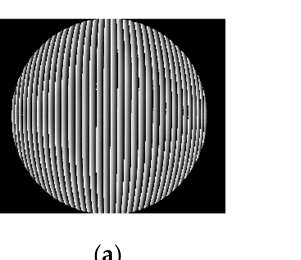
Wrapped phase of distorted transverse fringe-pattern transverse. phase of distorted transverse fringe-pattern transverse.